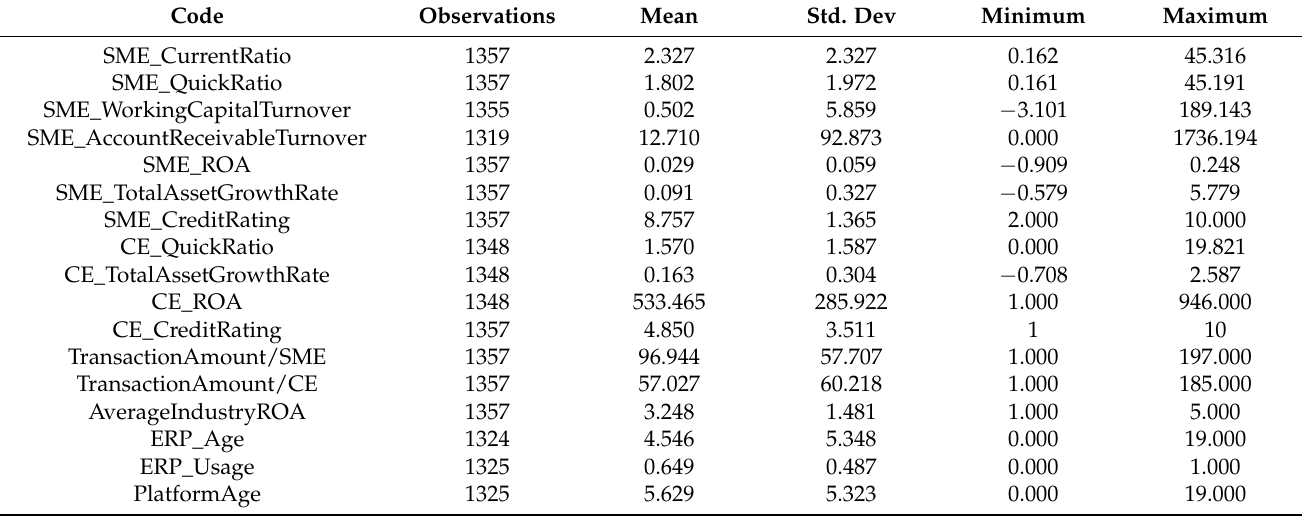
Table 3. Descriptive